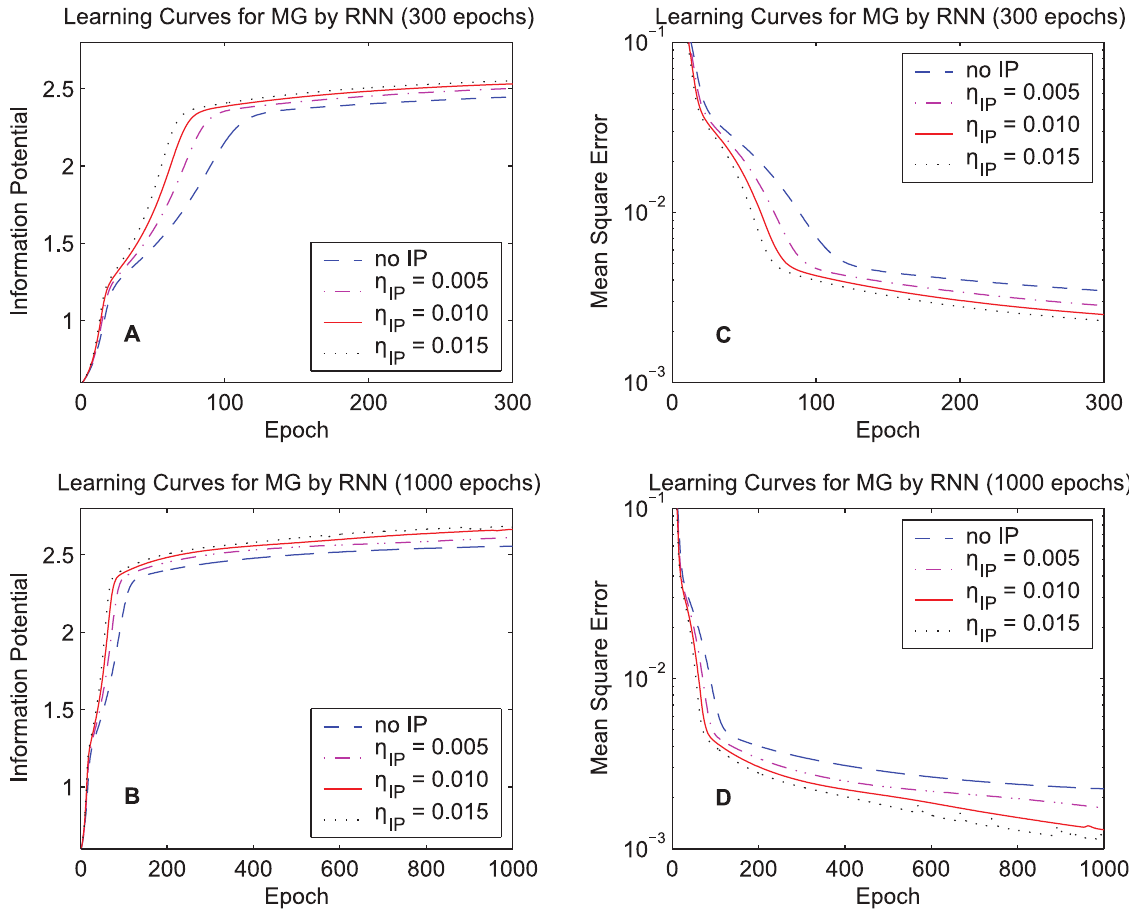
Figure 15. Learning curves by the RNN with different IP learning rates. The training data set ‘‘MG’’ is used. The initial IP learning rates g IP ~ 0 : 005 , g IP ~ 0 : 01 , g IP ~ 0 : 015 , and g IP ~ 0 (no IP) are used for comparison. Learning curves of the quadratic information potential: (A) 300 epochs. (B) 1000 epochs. Learning curves of the mean square error: (C) 300 epochs. (D) 1000 epochs.